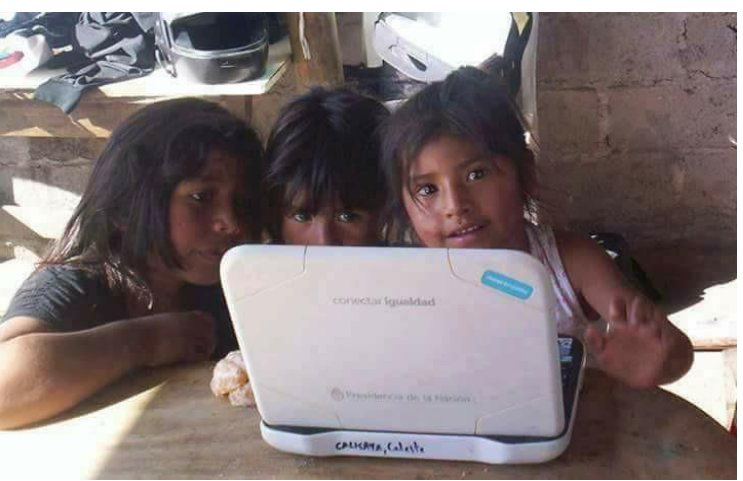
Figure 2. Conectar Igualdad reaches the most vulnerable sectors (Source: Google